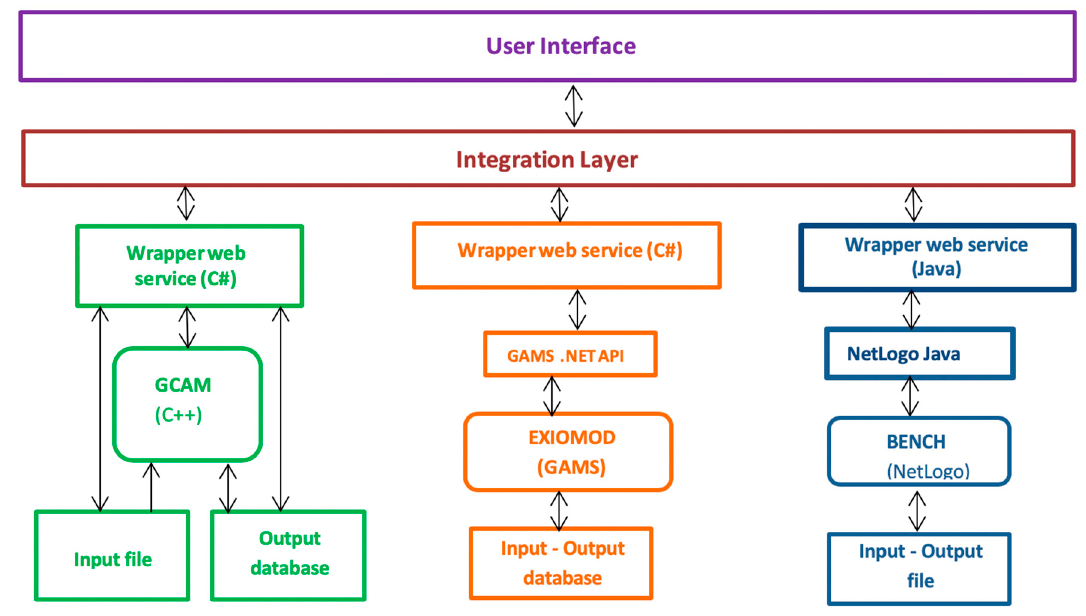
Figure 5. Architecture of the integrated climate-energy-economy system. Models are wrapped with WS and transformed to web-enabled components. The integration layer handles the communication between participating component models.